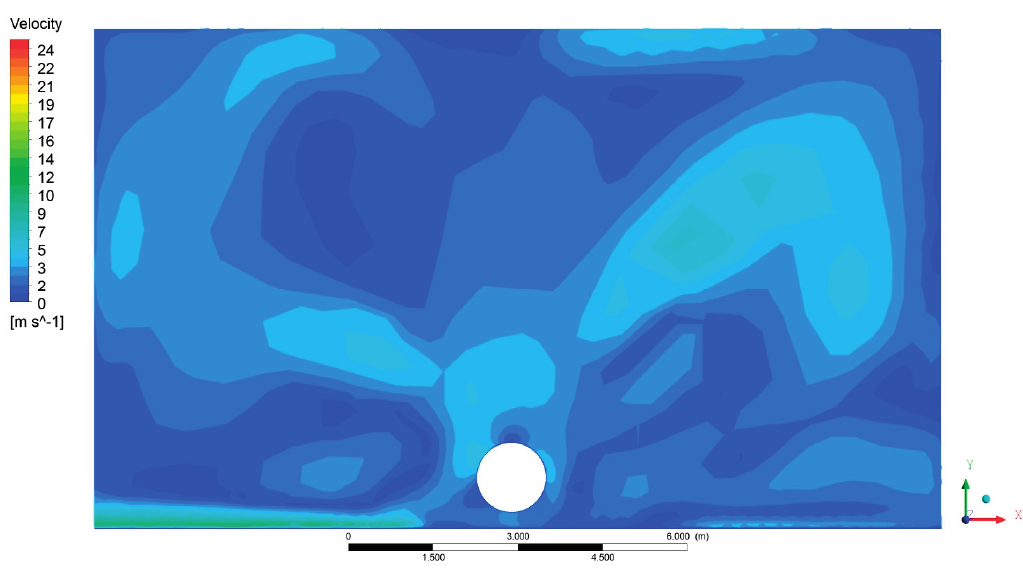
Figure 9. Air velocity obtained with CFD model in centre section of sprayer (B). Both the front and rear fans are activated. The fans are set to position